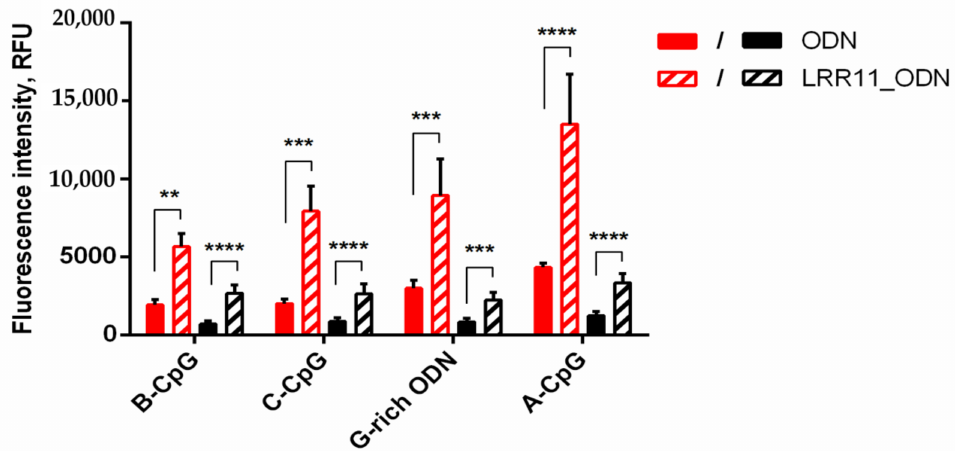
Figure 6. The LRR11 peptide affects the binding and uptake of ODNs by neutrophilic granulocytes. PMNLs (1 × 10 6 /mL) in HBSS/HEPES were incubated for 20 min at 37 ◦ C in 5% CO 2 with 1 µ M FAM-labeled ODN, supplemented or not with 1 µ M LRR11 peptide. Both the total ODN accumulation (red) and its intracellular constituent (black) were analyzed by flow cytometry. Surface fluorescence was quenched by trypan blue (TB) solution. Values represent the means ± SEM of FAM fluorescence intensities (RFU, relative fluorescence units) (n = 8). ** p < 0.01; *** p < 0.005, **** p < 0.001 for specified data pairs, as indicated by two-way ANOVA followed by Tukey’s multiple comparison test. Mean fluorescence intensities of unstained PMNLs were 62 ± 12 and 39 ± 5.6 without or after TB quenching,